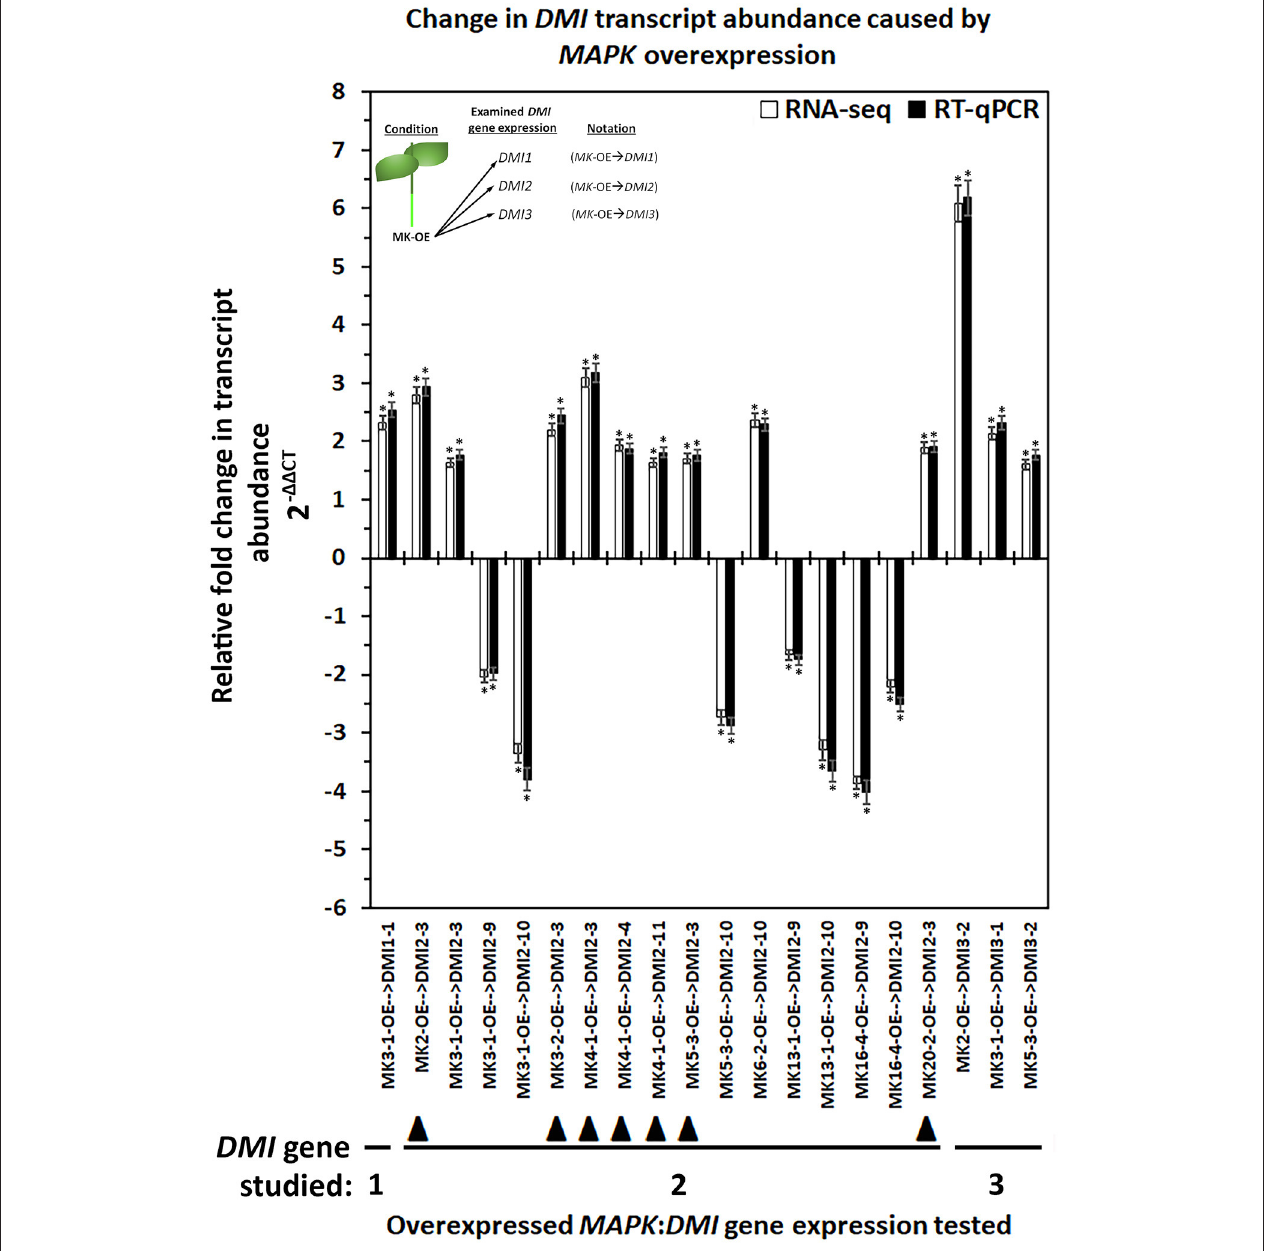
FIGURE 3 | The RTA results, presented as FC, for the DMI1 , DMI2 , and DMI3 gene family members that had exhibited differential expression in the defense MAPK -OE roots measured by RNA-seq and confirmed by RT-qPCR (Livak and Schmittgen, 2001; Wang and Wang, 2021). The data presented in this figure analyzes the MAPK -OE root RNA by RNA-seq and RT-qPCR. The sample analysis type presented below the x-axis provides the analysis parameter as MAPK -OE with the presented gene expression for the specific DMI gene denoted after the arrow ( → ) giving the sample designation as MAPK ( specific gene )-OE → DMI ( specific gene ). (*) The RNA-seq result was considered statistically significant at p < 0.001, Student’s t -test; RT-qPCR expression was calculated by 2 − 11 C T to enumerate the RTA, presented as FC in the y-axis (Livak and Schmittgen, 2001; Klink et al., 2021a). (*) The result is statistically significant at p < 0.05, Student’s t -test (Yuan et al., 2006). The DMI genes that had contrasting expression (an FC that was increased [I] in the MAPK -OE RNA-seq and RT-qPCR analyses (Figure), and an FC that was decreased [D] in MAPK -RNAi RNA-seq, and RT-qPCR analyses ( Figure 4 ) have been referred to as an MAPK -OE:RNAi couplet as designated in the Results subsection: Cross-comparative analyses involving MAPK -OE and MAPK -RNAi experiments) have been indicated with the designated black triangle ( N ). This designation was made for MAPK2 -OE:RNAi → DMI2-3 (I:D), MAPK3-2 -OE:RNAi → DMI2-3 (I:D), MAPK4-1 -OE:RNAi → DMI2-3 (I:D), MAPK4-1 -OE:RNAi → DMI2-4 (I:D), MAPK4-1 -OE:RNAi → DMI2-11 (I:D), MAPK5-3 -OE:RNAi → DMI2-3 (I:D), and MAPK20-2 -OE:RNAi → DMI2-3 (I:D). (Figure) presents data for 20 couplets. Details for these experiments can be found in Supplementary Table 6 . Please refer to the Materials and Methods subsections: RNA-seq gene expression analyses of transgenic MAPK -OE and -RNAi root RNA, and Real-time quantitative PCR (RT-qPCR), for details. Inset, upper left corner of the histogram provides that flow chart that relates to the sample naming scheme found at the x-axis.